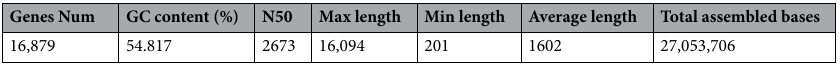
Table 1. Summary of splicing length distribution in